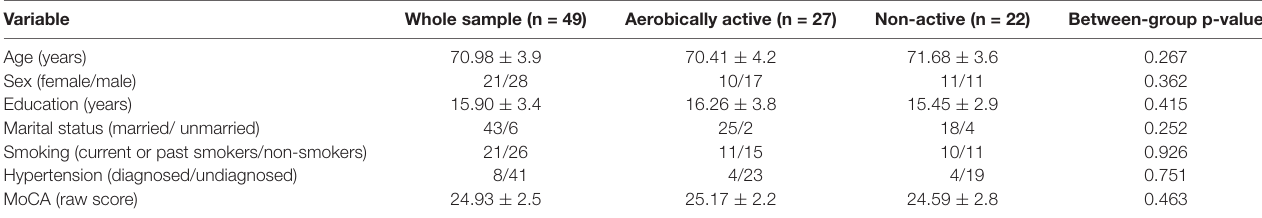
TABLE 1 | Background characteristics of the participants (means ± SD). Variable